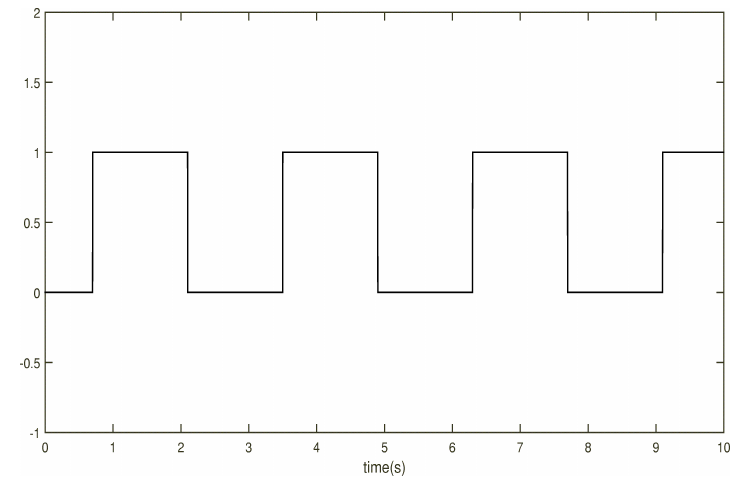
Fig. 2. Switching signal of system (1) with ADT.